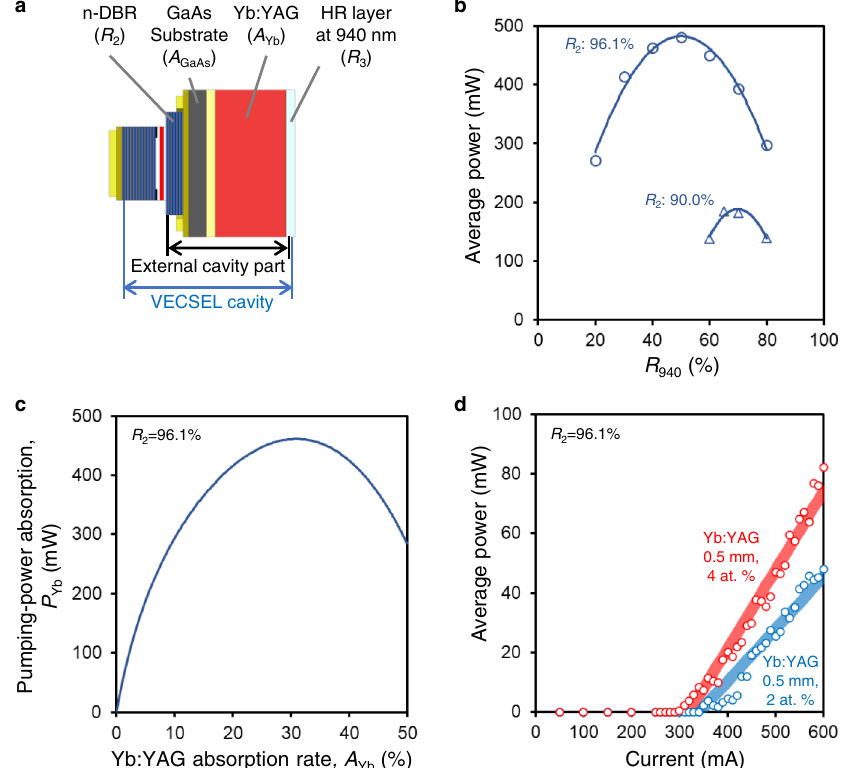
Fig. 2 | Design of the integrated VECSEL cavity. a VECSEL cavity model. b Measured VECSEL output power for R 2 =90.0% and 96.1%. The Yb:YAG was replaced by a 940nm OC (re fl ectance: R 940 ). The distance between the GaAs sub- strate and OCwas0.5mm. c Analyzed pumping-power absorption of Yb:YAG( P Yb ) versus Yb:YAG absorption rate ( A Yb ) for R 2 =96.1%. Other parameters were set as